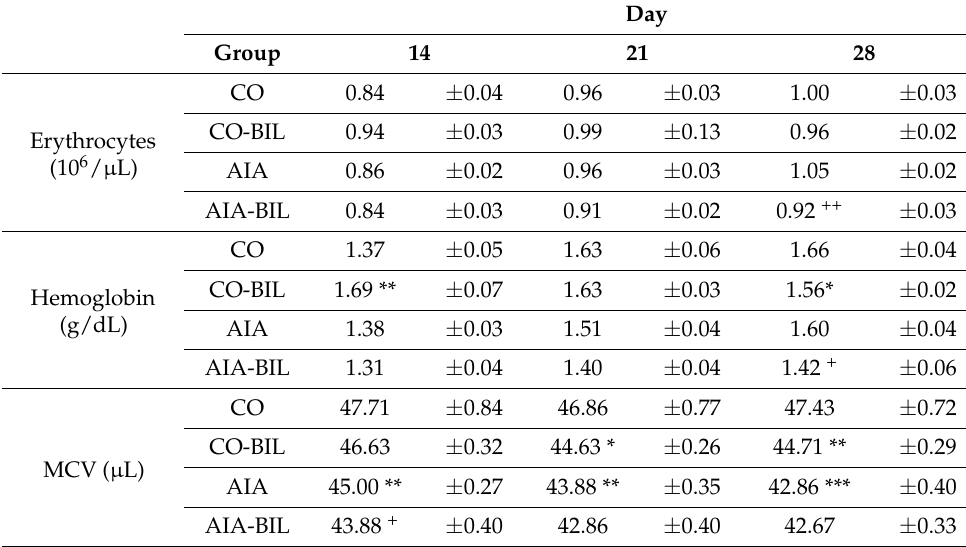
Table 1. Changes in erythrocytes (number of erythrocytes, hemoglobin content and corpuscular volume) parameters during the course of the experiment. MCV—mean corpuscular volume. CO— control group, CO-BIL—control group administered with UCB 200 mg/kg of body weight daily i.p. from day 14, AIA—group with adjuvant induced arthritis, AIA-BIL—group with adjuvant induced arthritis administered with UCB 200 mg/kg of body weight daily i.p. from day 14. Results are expressed as mean ± SEM, n = 7–8. Significant difference between groups CO and CO-BIL, CO and AIA: *** p < 0.001 vs. CO, ** p < 0.01 vs. CO, * p < 0.05 vs. CO. Significant difference between groups AIA and AIA-BIL: ++ p < 0.01 vs. AIA, + p < 0.05 vs.